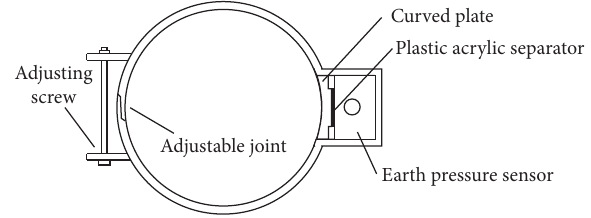
Figure 2: Schematic view of retractable